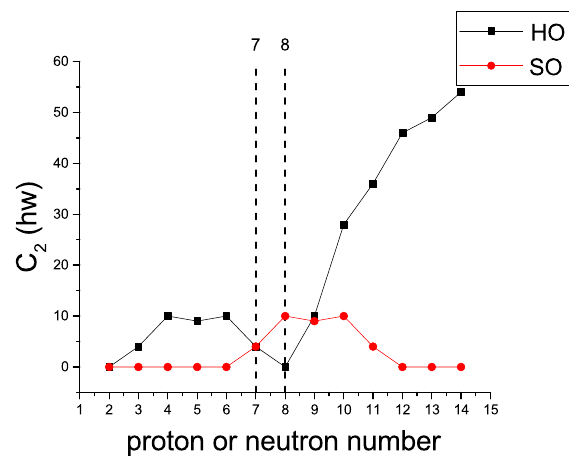
Figure 1. The eigenvalues of the second order Casimir operator of the SU (3) algebra versus the proton ( Z ) or neutron number ( N ). Equation (3) has been used along with the irreps ( λ,μ ) of Table 1 of Ref. [15]. Shape coexistence is predicted among pro- ton or neutron numbers 7 − 8.